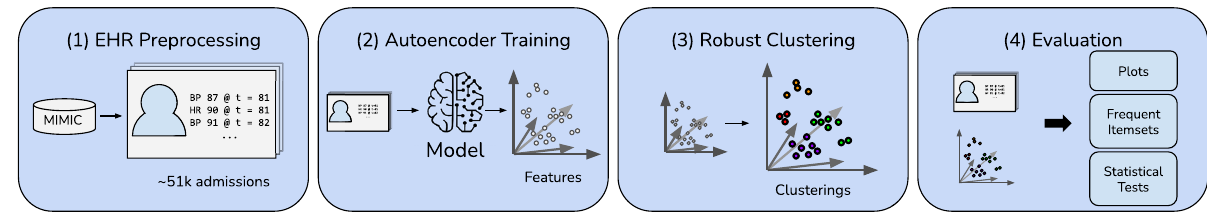
Figure 6. Data processing pipeline. First, medical data is extracted from MIMIC, converted into a format suitable for training the model, and normalized. In the second step, the deep autoencoder model is trained, and a feature vector for each admission is computed. Step 3 is clustering, which first generates clustering candidates through the application of standard clustering algorithms and then ensures the robustness of each clustering using a bootstrapping process. Clusterings that are not robust are filtered out. Finally, the clusterings are evaluated by creating plots, performing statistical tests, and mining frequent ICD